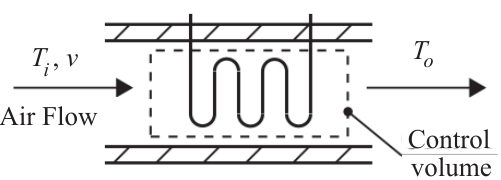
Figure 2. The Thermal Unit (TU) module